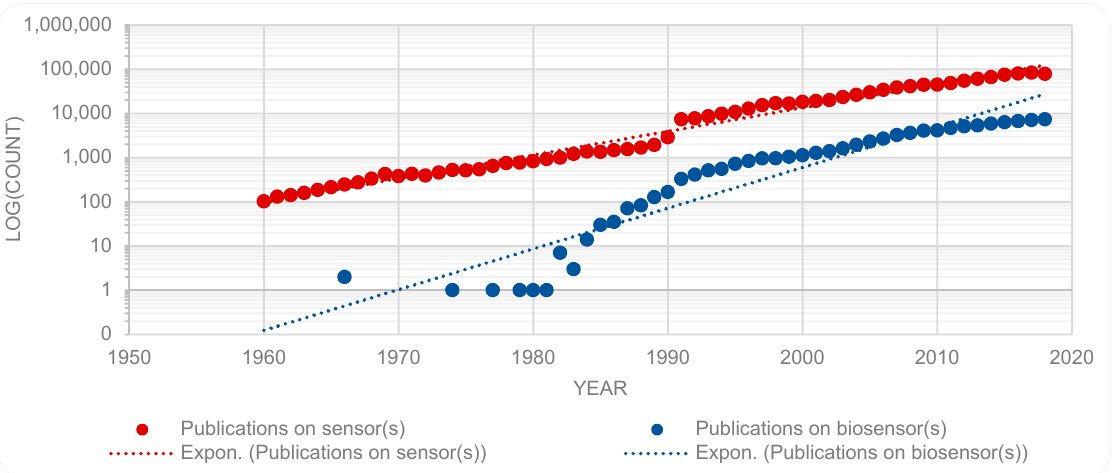
Figure 5. A comparison between the publications on biosensors as compared with publications on sensors (semi logarithmic scale).